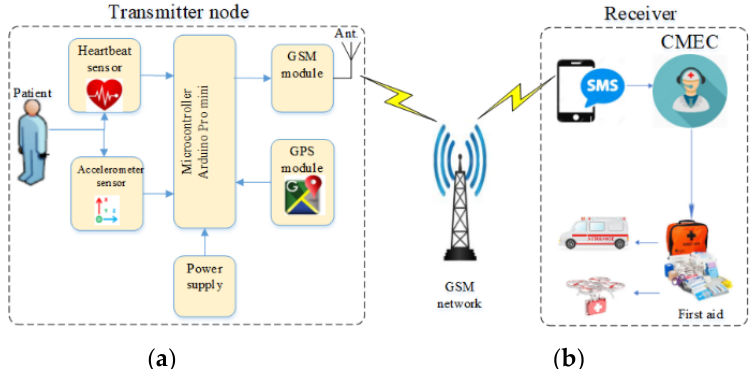
Figure 1. Block diagram of the proposed AWHMS, including ( a ) the transmitter node and ( b ) receiver.